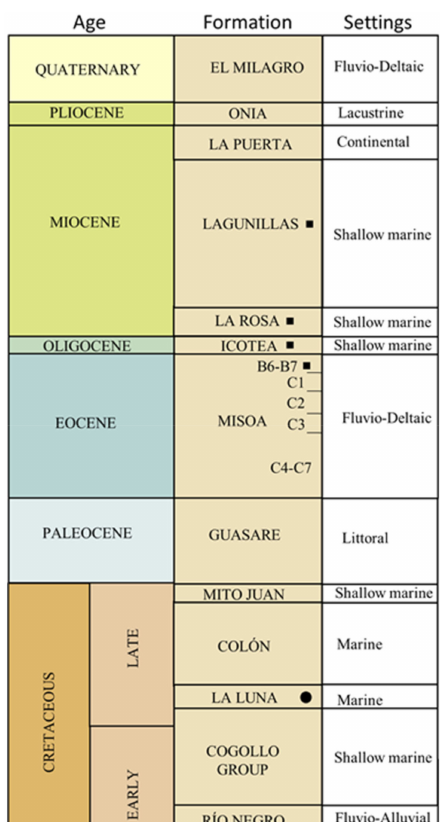
Figure 2. Stratigraphic units in the northern Bolivar Coastal Complex. Note: black circles and black squares indicate source rocks and reservoir intervals,